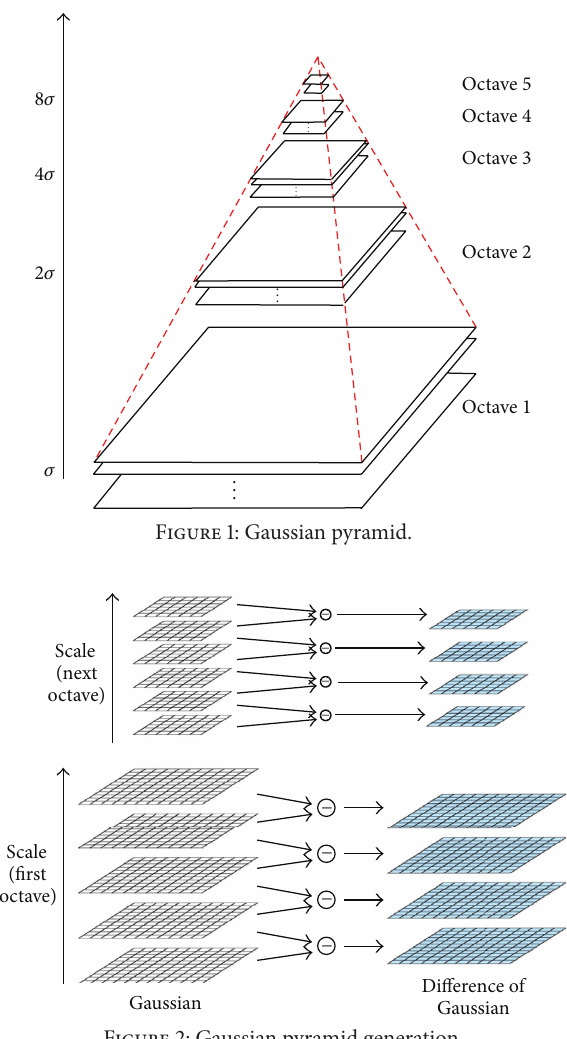
Figure 2: Gaussian pyramid